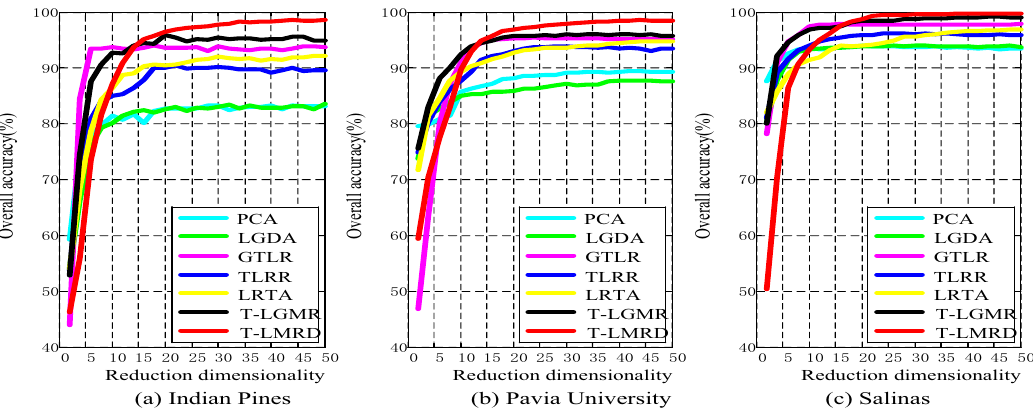
Figure 7. Overall accuracy with different dimensionalities. ( a ) Indian Pines; ( b ) Pavia University; ( c ) Salinas.